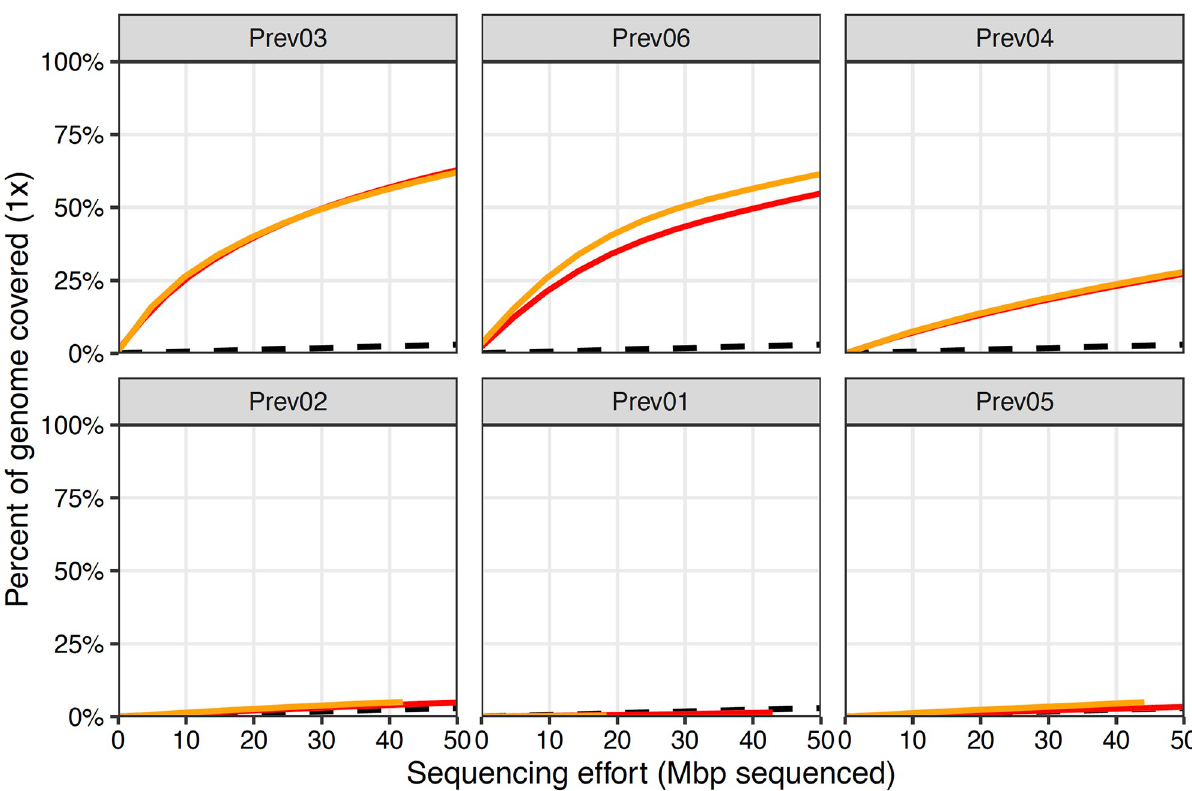
Fig 5. Selective amplification of P. melanogenica using six swga2.0 -designed primer sets (Prev01-Prev06) identified three primer sets (Prev03, Prev06, and Prev04) that can amplify the target genome but not the background DNA. Red and yellow lines indicate the percent of the target genome covered at 1 × depth from sequencing each of the two replicate amplification experiments. The black dashed lines represent sequencing coverage of the unamplified samples. While five of the six sets resulted in greater sequencing coverage of the target genome compared to unamplified controls, two were only marginally better. By contrast, sequencing coverage of the amplicons from three of the sets was substantially better than the coverage of the unamplified samples.